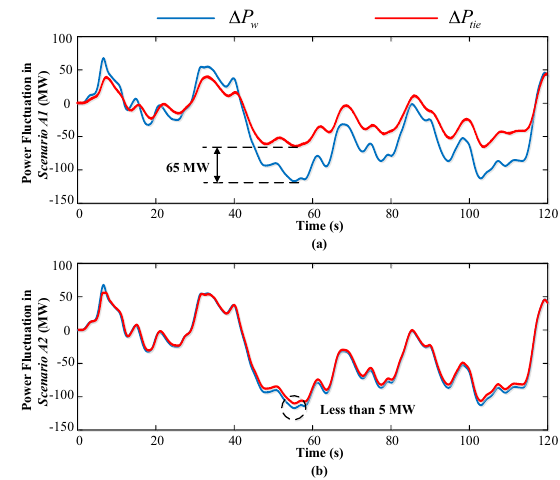
Fig. 10 The wind power fluctuation (cid:31) P w and active power deviation on tie-line (cid:31) P tie . a The power curves in Scenario A1 , b the power curves in Scenario